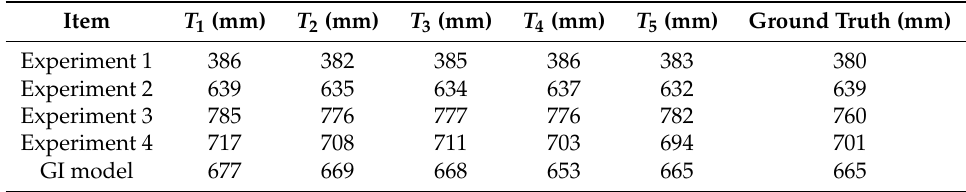
Table 1. Distance estimation results with different